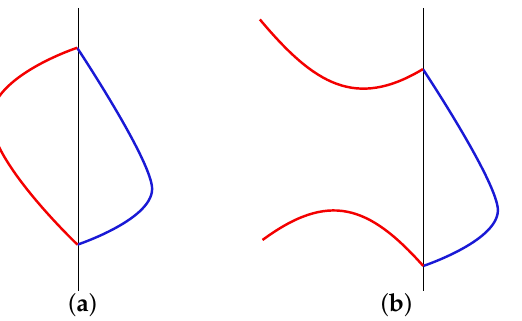
Figure 1. Some possible connections between both side branches. ( a ) Cycle shape appears; ( b ) It is not a cycle.